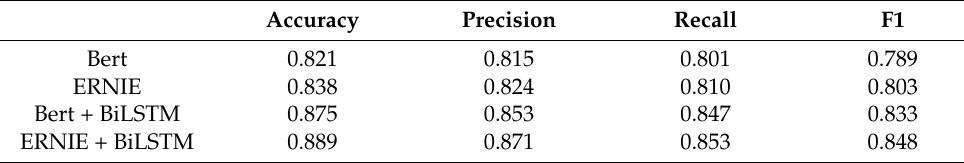
Table 6. Performance Comparison of Different Feature Extraction